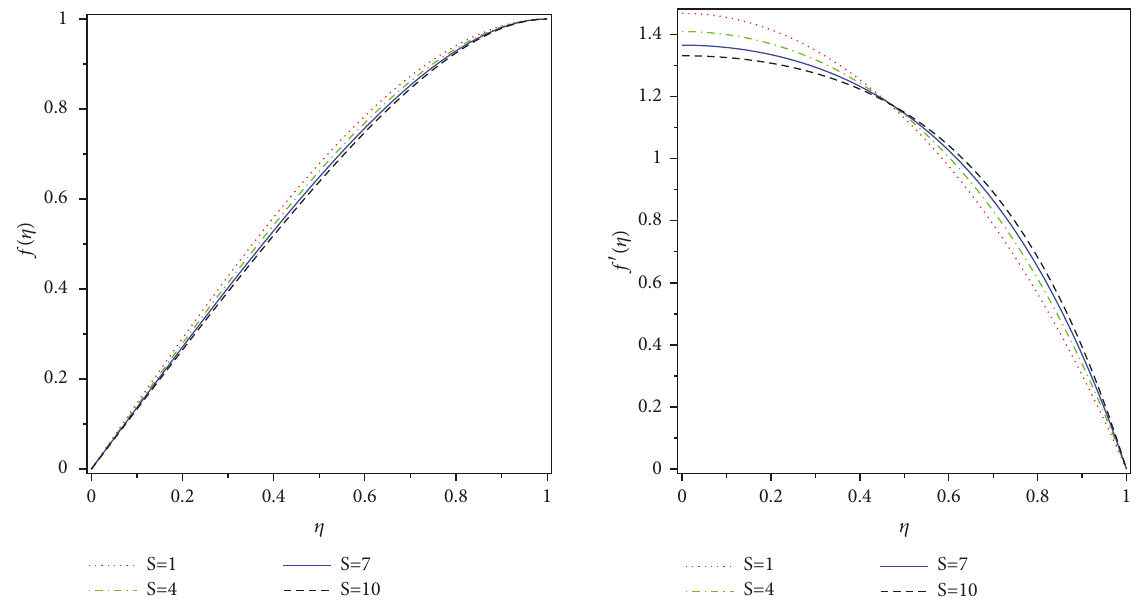
Figure 2: 𝑓(𝜂) and 𝑓 󸀠 (𝜂) for positive values 𝑆 when 𝑀 = 1 , 𝛾 = 0.4 .